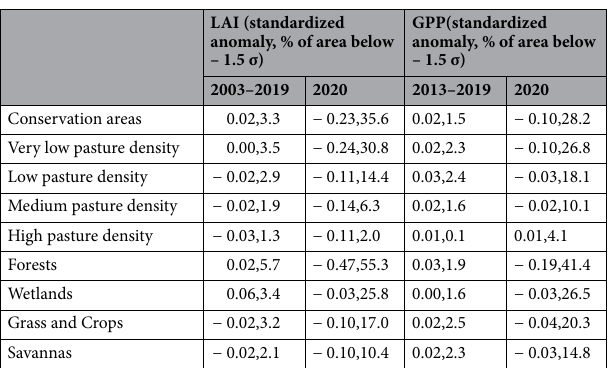
Table 2. Standardized anomalies of LAI and GPP and the percentage of area where the standardized anomalies are less than − 1.5 σ, stratified over conservation areas and regions with different pasture density and land cover types, averaged across 2003–2019 and for 2020.